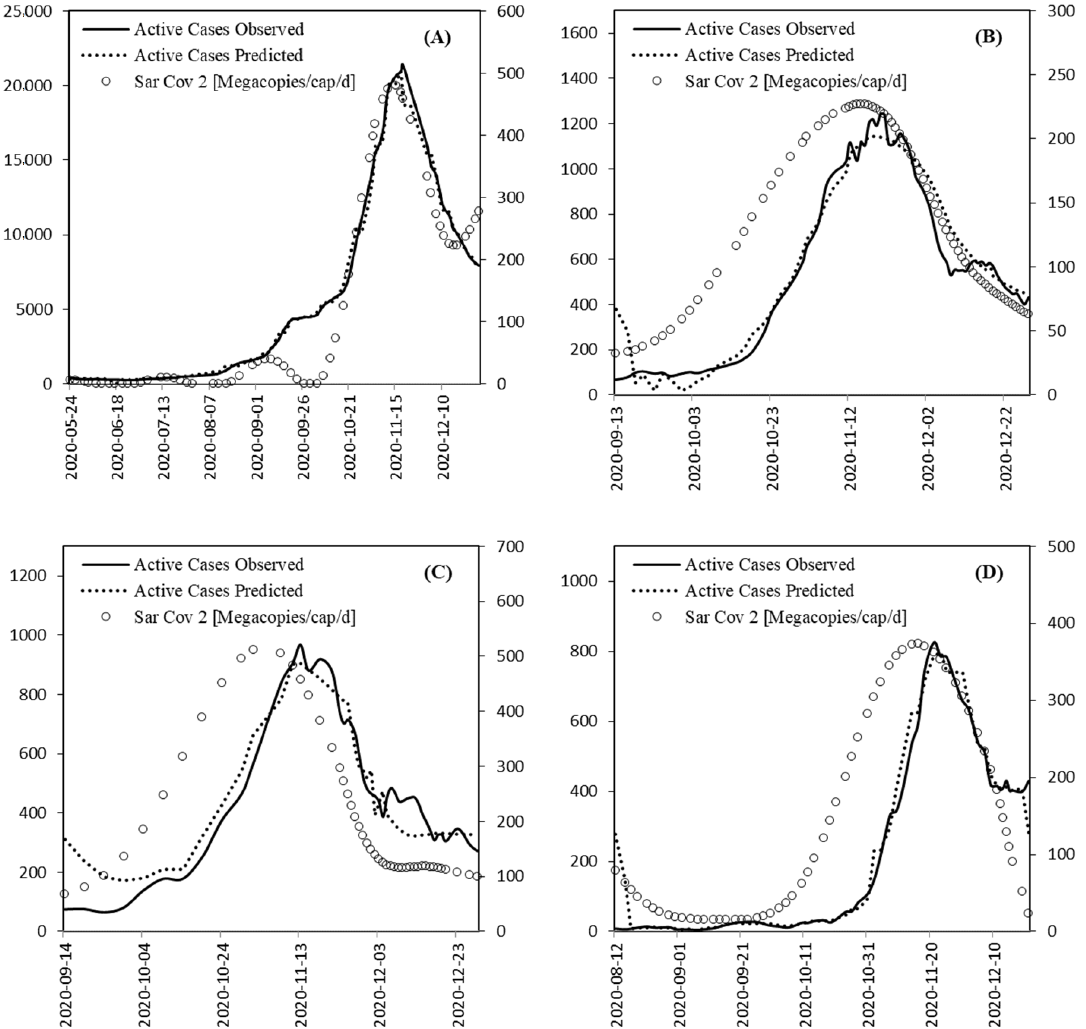
Figure 8. Data timeline of smoothed and normalized SARS-CoV-2 titer values (Megacopies/cap/d) versus active cases in observed/predicted timelines for the best models in WWTPs ( A – D ).